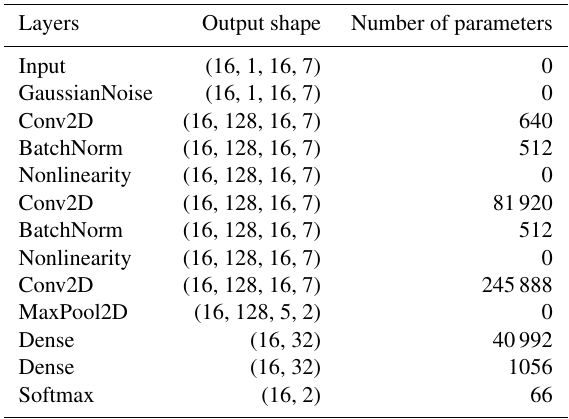
Table 6. Layers, output shapes, and number of parameters for the CNN model.